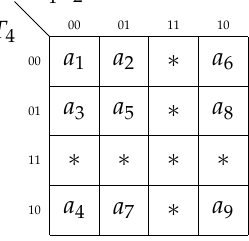
Figure 6. Outcome of state assignment for Mealy FSM S 1